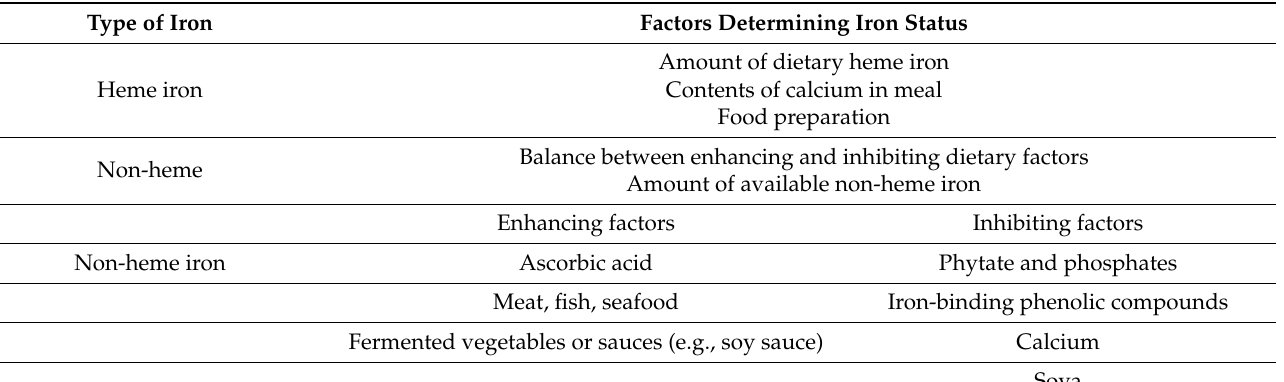
Table 4. Dietary factors that may influence the iron absorption